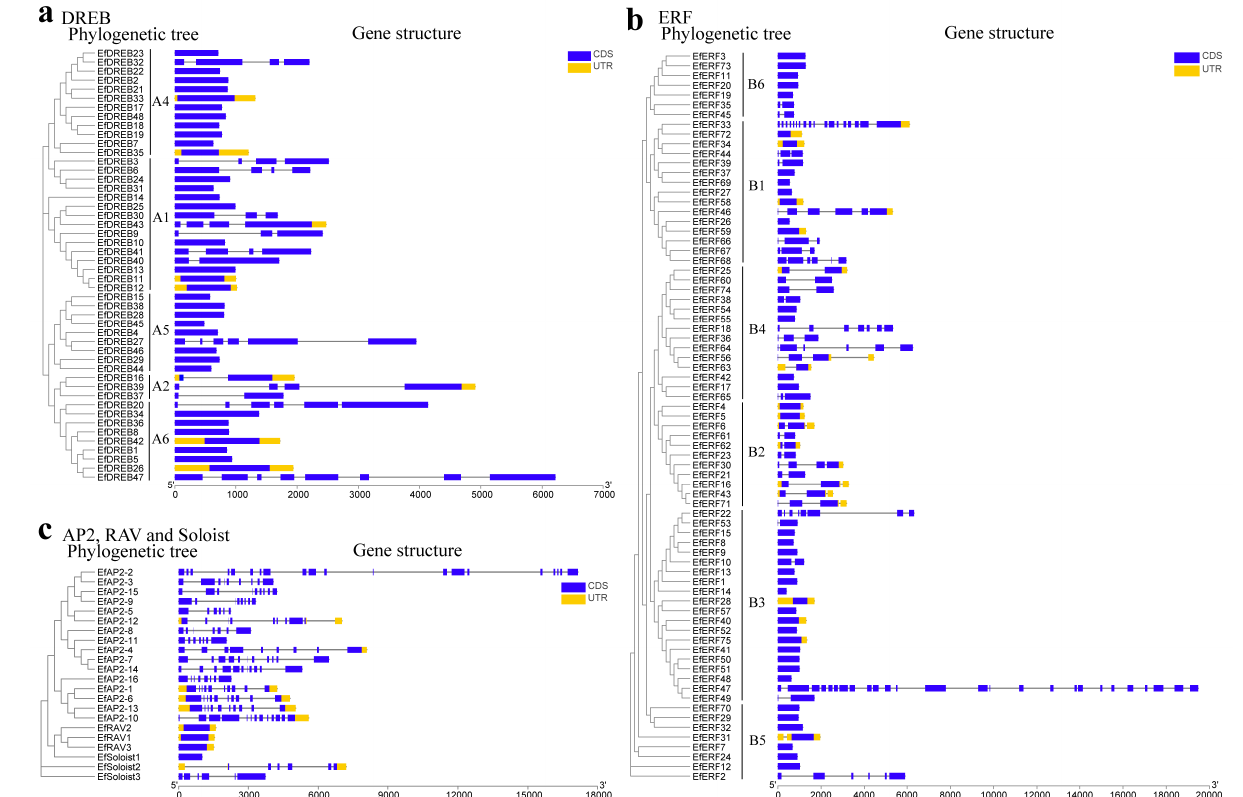
Figure 4. Gene structure cluster analysis of EfAP2/ERF family genes according to phylogenetic relationship. ( a ) Gene structure of EfDREB subfamily. ( b ) Gene structure of EfERF subfamily. ( c ) Gene structure of EfAP2 , EfRAV , and EfSoloist